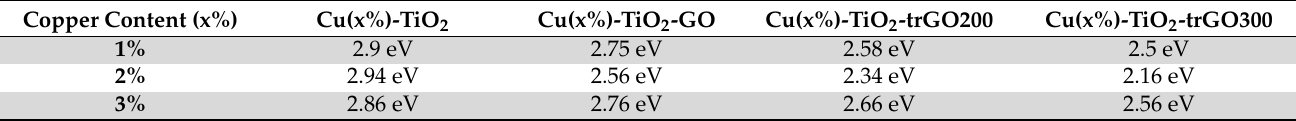
Table 1. Band gap (E g ) calculated for the different composites using the Tauc